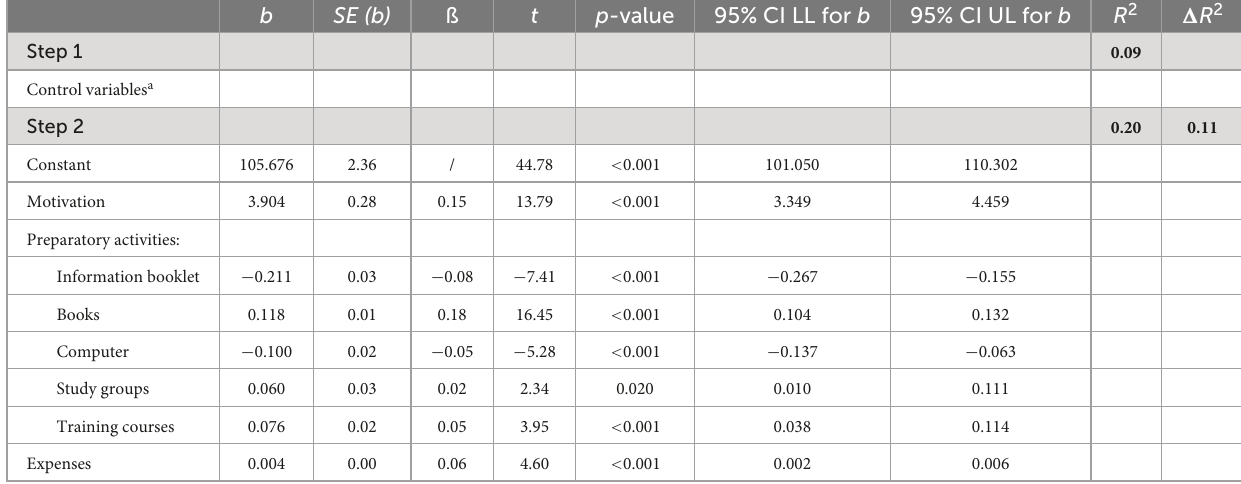
TABLE 3 Hierarchical multiple regression analysis predicting the TMS-score.